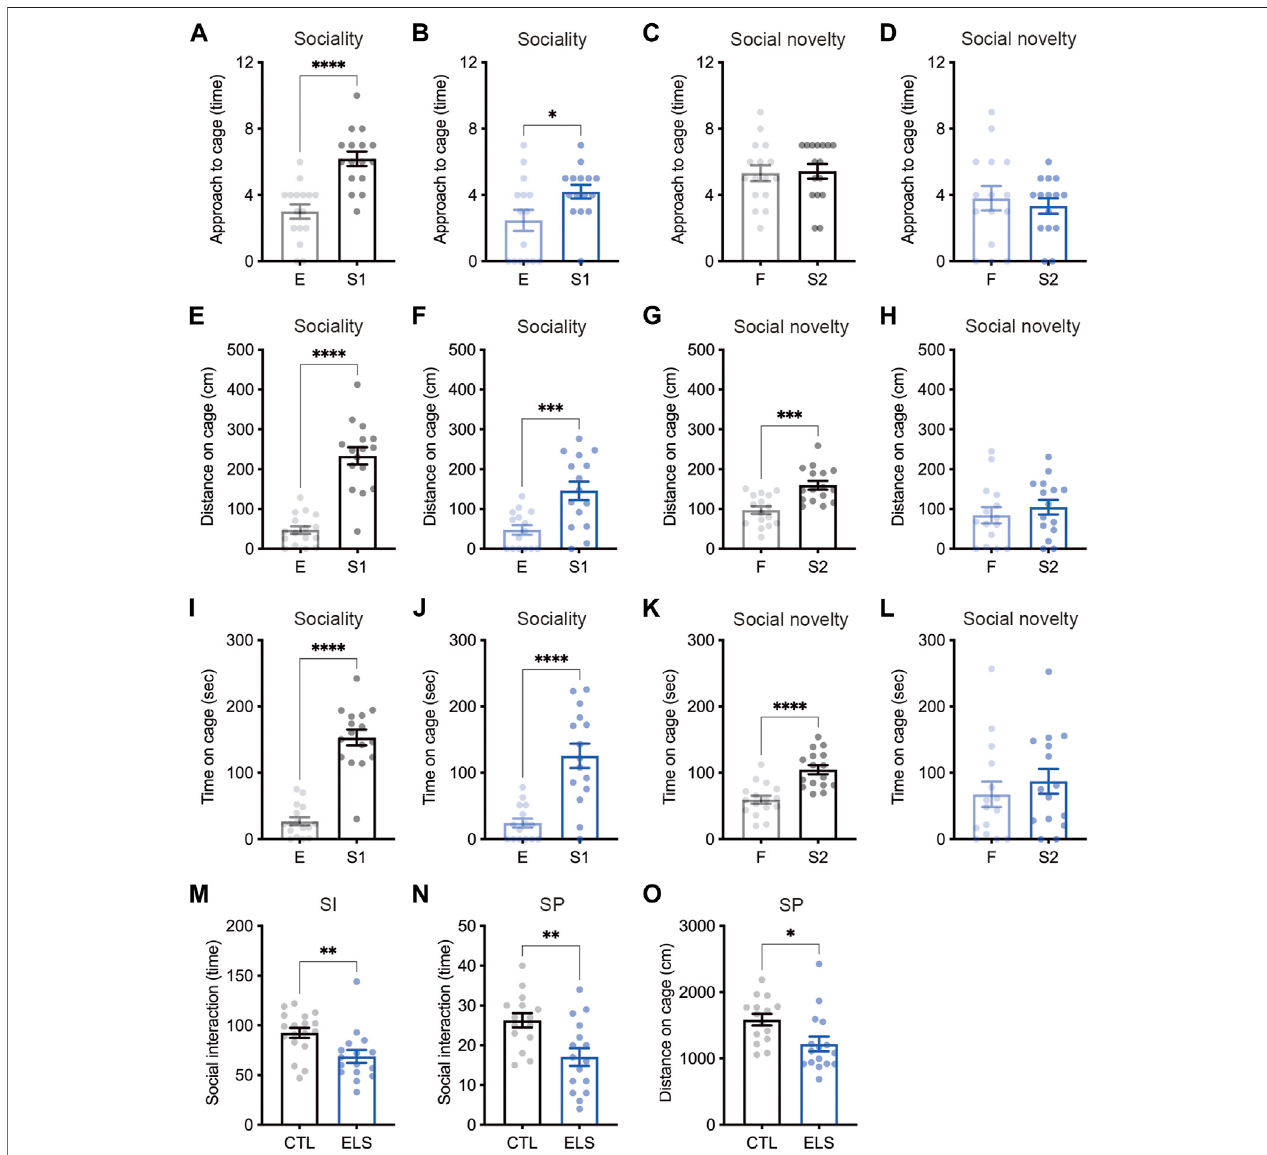
FIGURE2| SocialimpairmentsinducedbyELS. (A – L) Quanti fi cationsofthree-chambersocialinteractiontestresults.Thenumbersofapproaches (A – D) ,distance (E – H) , and time (I – L) were shown during the 2nd trial (sociability behavior) (A, B, E, F, I, J) and the 3rd trial (social novelty behavior) (C, D, G, H, K, L) of three-chamber socialinteractiontest(3CSI),respectively.SociabilityandsocialnoveltywereimpairedinadolescentELSmice.CTLwasshowninblack,andtheELSwasshowninblue. E, empty; S1, stranger mouse 1; S2, stranger mouse 2; SI, social interaction test. (M) Reduced number of social interactions in adolescent ELS mice. (N, O) Quanti fi cations of social preference in ELS mice. The number of interaction (N) and distance (O) were reduced in ELS mice. SP, social preference test. Data are presented as means ( ± SEM). Asterisks indicate ****p < 0.0001, ***p < 0.001, ** p < 0.01, * p < 0.05, unpaired t -test, n (cid:2) 15 – 16/condition for 3CSI and SP, n (cid:2) 16 – 18/ condition for SI.